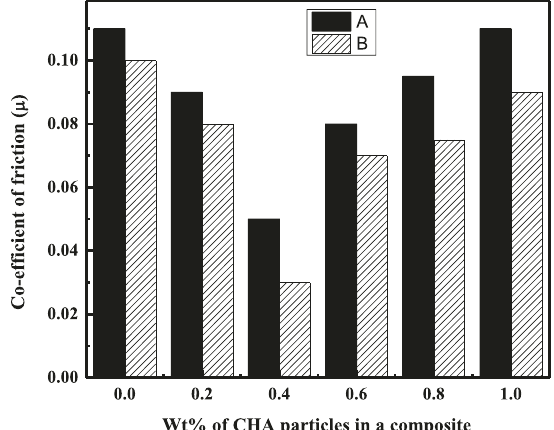
Fig. 11 Coef fi cient of friction of CC vs. Wt% concentration of the fi ller in the composite conducted at 2 N applied load and 300 m sliding distance at room temperature in A dry and B wet